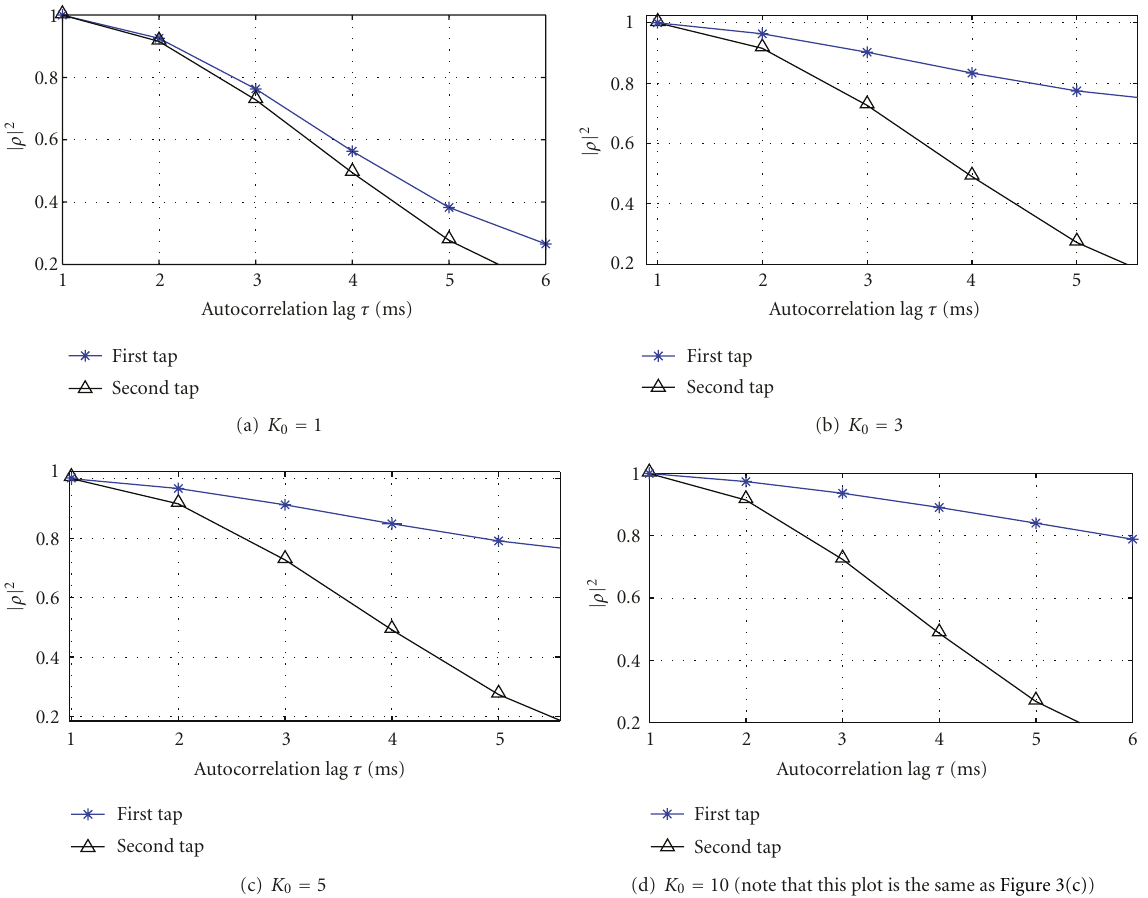
Figure 4: Squared-envelope of the autocorrelations of the first and second taps for common parameters θ (0) 0 = π/ 5, v = 20 m/s, and the set of { K 0 } .